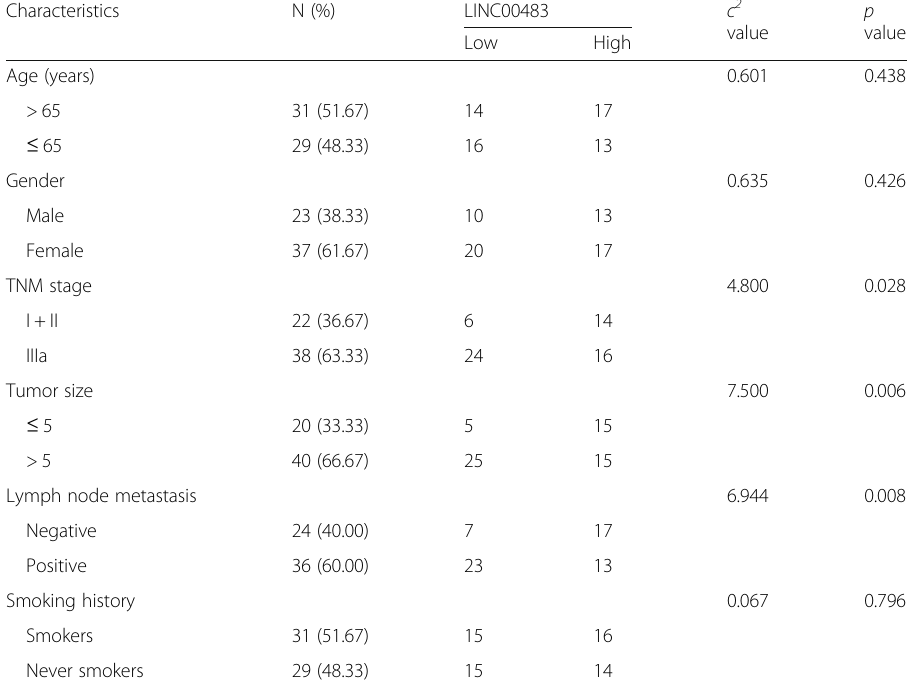
Table 1 The correlation between LINC00483 RNA level and clinicopathological characteristics as analyzed using chi-square